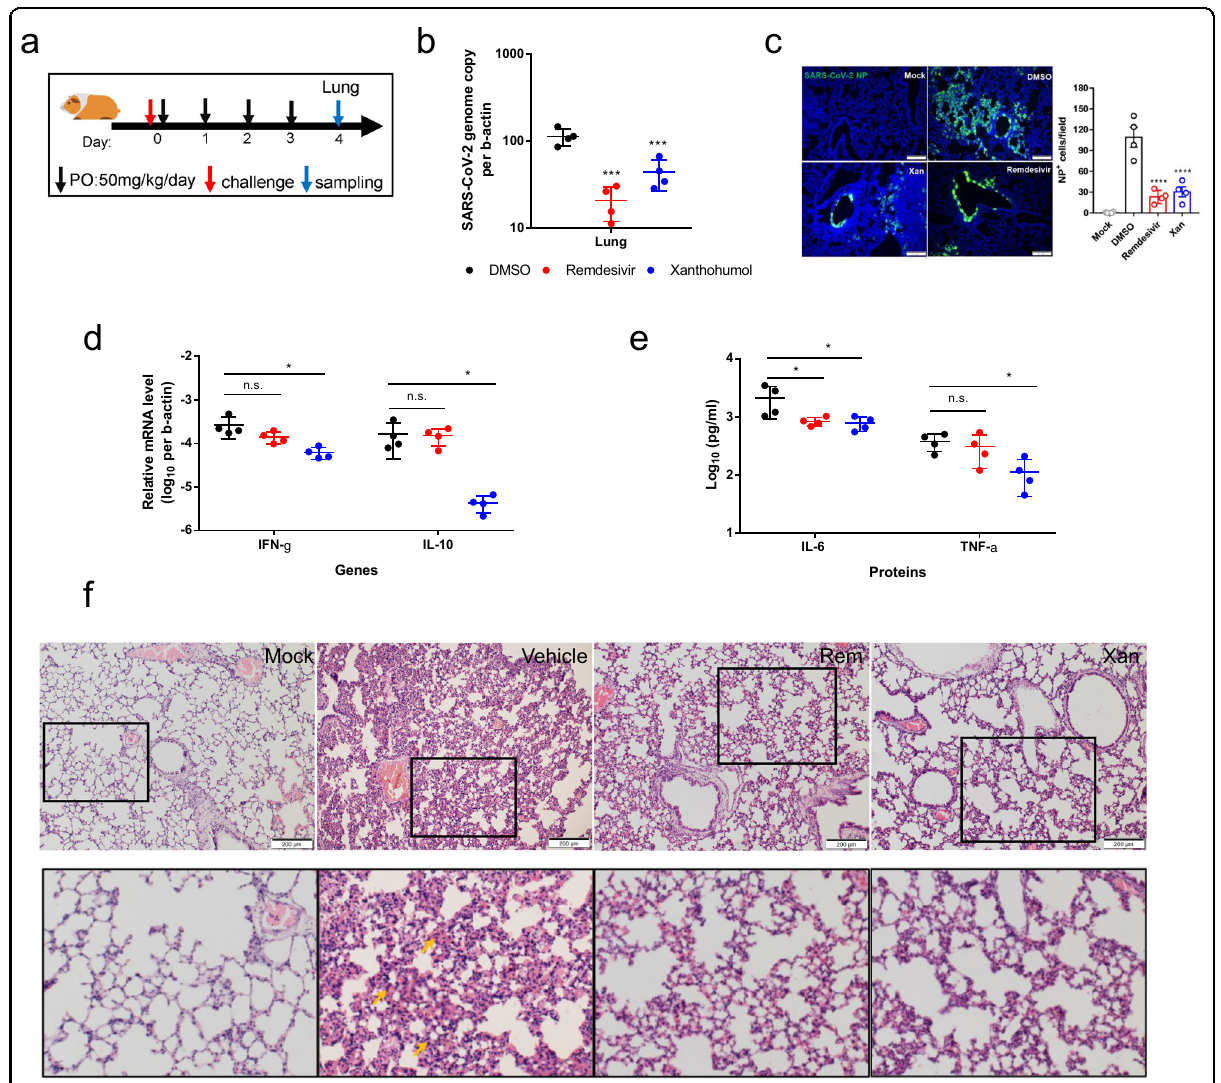
Fig. 5 Xanthohumol inhibits SARS-CoV-2 replication in vivo. a Experimental design of the oral Xanthohumol regimen. b Viral yield in the hamster lung ( n = 4) was harvested at 4 dpi and titrated by RT-qPCR assay. Data represent mean ± SD. One-way ANOVA was used for comparison with the DMSO control group. For all statistical analyses above, * P < 0.05, ** P < 0.01, and *** P < 0.001. c Representative images of viral NP distribution in lung tissues section from infected hamsters treated with DMSO or Xanthohumol or Remdesivir, at 4 dpi. SARS-CoV-2 NP (green) and cell nuclei (blue) were stained. Scale bar, 200 µm. These representative images were selected from a pool of 10 images captured in 4 hamsters per group. NP-positive cells per 50× fi eld per the lung section of a hamster were quanti fi ed. One-way ANOVA followed by Dunnett ’ s post test and compared with DMSO control. **** P < 0.0001. d The mRNA expression of IFN- γ and IL-10 in hamster lung was quanti fi ed at 4 dpi using qRT-PCR assays. One-way ANOVA was used for comparison with the DMSO group. e The cytokines IL-6 and TNF- α levels in hamster serum samples were quanti fi ed at 4 dpi using ELISA. One-way ANOVA was used for comparison with the DMSO group. f Representative images of H&E-stained lung tissue section from the hamsters treated with different groups indicated, illustrating the severity of alveolar in fi ltration (gold arrows). The lower panel are enlarged images corresponding to each black box of the upper panel. These representative images were selected from a pool of 10 images captured in 4 hamsters per group. Scale bar, 200 μ fi tness. Centralized via LDs, future studies are desired to metabolism (Fig. 2). TGs serve as an important cellular energy source and are lipolytically broken down into FAs, elucidate the interplay among the LD-residential viral NP, which are then imported into mitochondria and con- the LD synthetase DGAT, and the LD stabilizer ADRP. sumed by β -oxidation to produce ATP 22 . The result Intriguingly, distinct lipidomic patterns were observed in cells infected with SARS-CoV-2 or SARS-CoV at 8 hpi, indicates that SARS-CoV-2 may require higher demand of when SARS-CoV-2 infection markedly perturbs TG energy supply to maximally fuel its genome and protein